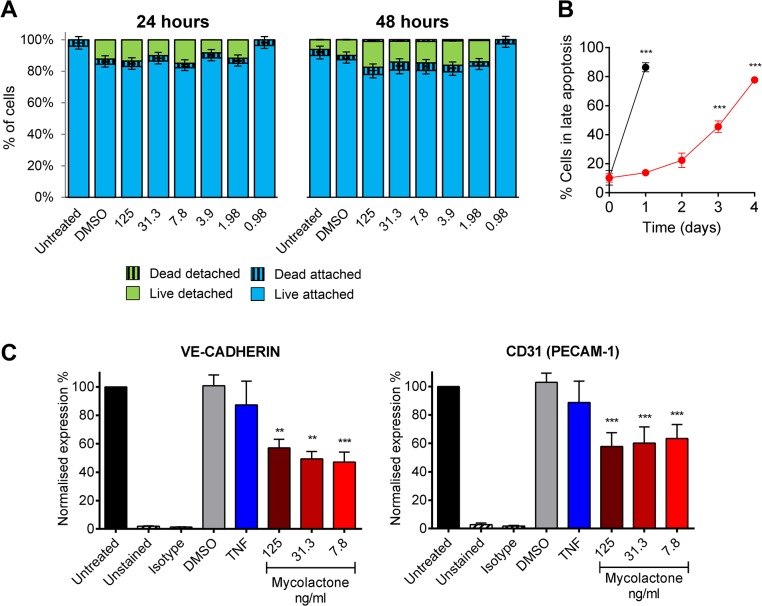
Mycolactone causes detachment of endothelial cells, apoptosis in 3–4 days, and depletes CD31 (PECAM-1) and VE-cadherin the surface.Human dermal microvascular endothelial cells were exposed to various concentrations of mycolactone (MYC), 10ng/ml TNF, 1μM staurosporin or 0.025% DMSO (solvent control) as appropriate. A. Both attached and detached cells were subjected to Calcein/EtBr staining for live/dead cells. The proportion of cells that were either attached or detached and alive (Calcein +/EtBr-), and attached or detached and dead (Calcein-/EtBr +) are expressed as a % of the total population of cells. mean±SEM, n = 3. B. HDMVECs were exposed to 7.8ng/ml mycolactone over a timecourse. Cells were then analysed by confocal microscopy following staining of cells with no-wash reagents. CellEvent caspase-3/7 green detection reagent identified cells undergoing apoptosis, alongside PI and DRAQ5. The number of cells in late apoptosis (positive for both active caspase 3/7 and PI) were counted in 3 fields and expressed as a proportion of total cells (DRAQ5 stained) Mean±SEM (n = 3). C. Cells were harvested and subjected to flow cytometry for VE-Cadherin and CD31 (PECAM-1). MFIs are expressed as % of untreated cells (mean±SEM, n = 4). Unstained and isotype bars are for untreated cells. **, P<0.01; ***, P<0.001.